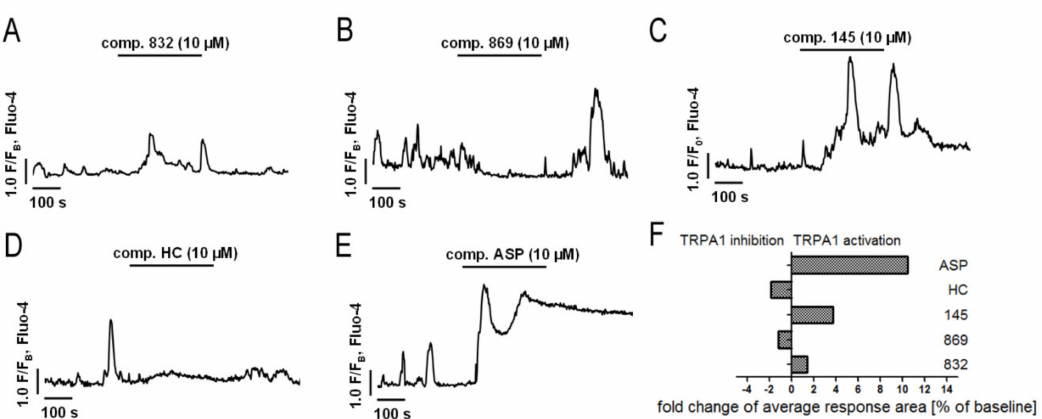
Figure 4. Both inhibition and activation of TRPA1 channels a ff ect Ca 2 + signals in MRC-5 cells. Traces show representative Ca 2 + responses recorded in MRC-5, before and after acute application of one of the investigated compounds: ( A ) 832 (10 µ M), n = 22; ( B ) 869 (10 µ M), n = 23; ( C ) 145 (10 µ M), n = 28; ( D ) HC-030031 (10 µ M), n = 25; ( E ) ASP7663 (10 µ M), n = 23. ( F ) Fold change of TRPA1 inhibition or activation after an acute application of investigated compounds.